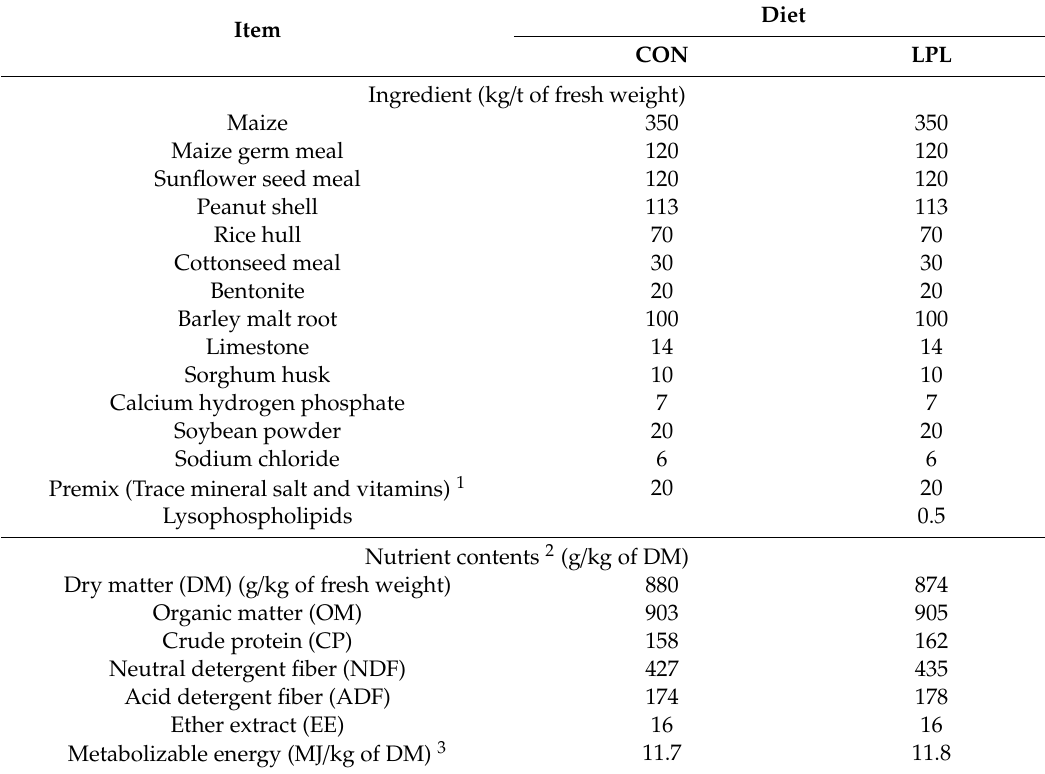
Table 1. Ingredients and nutrient contents of experimental diets supplemented without (CON) or with (LPL) lysophospholipids. Diet Item CON LPL Ingredient (kg / t of fresh